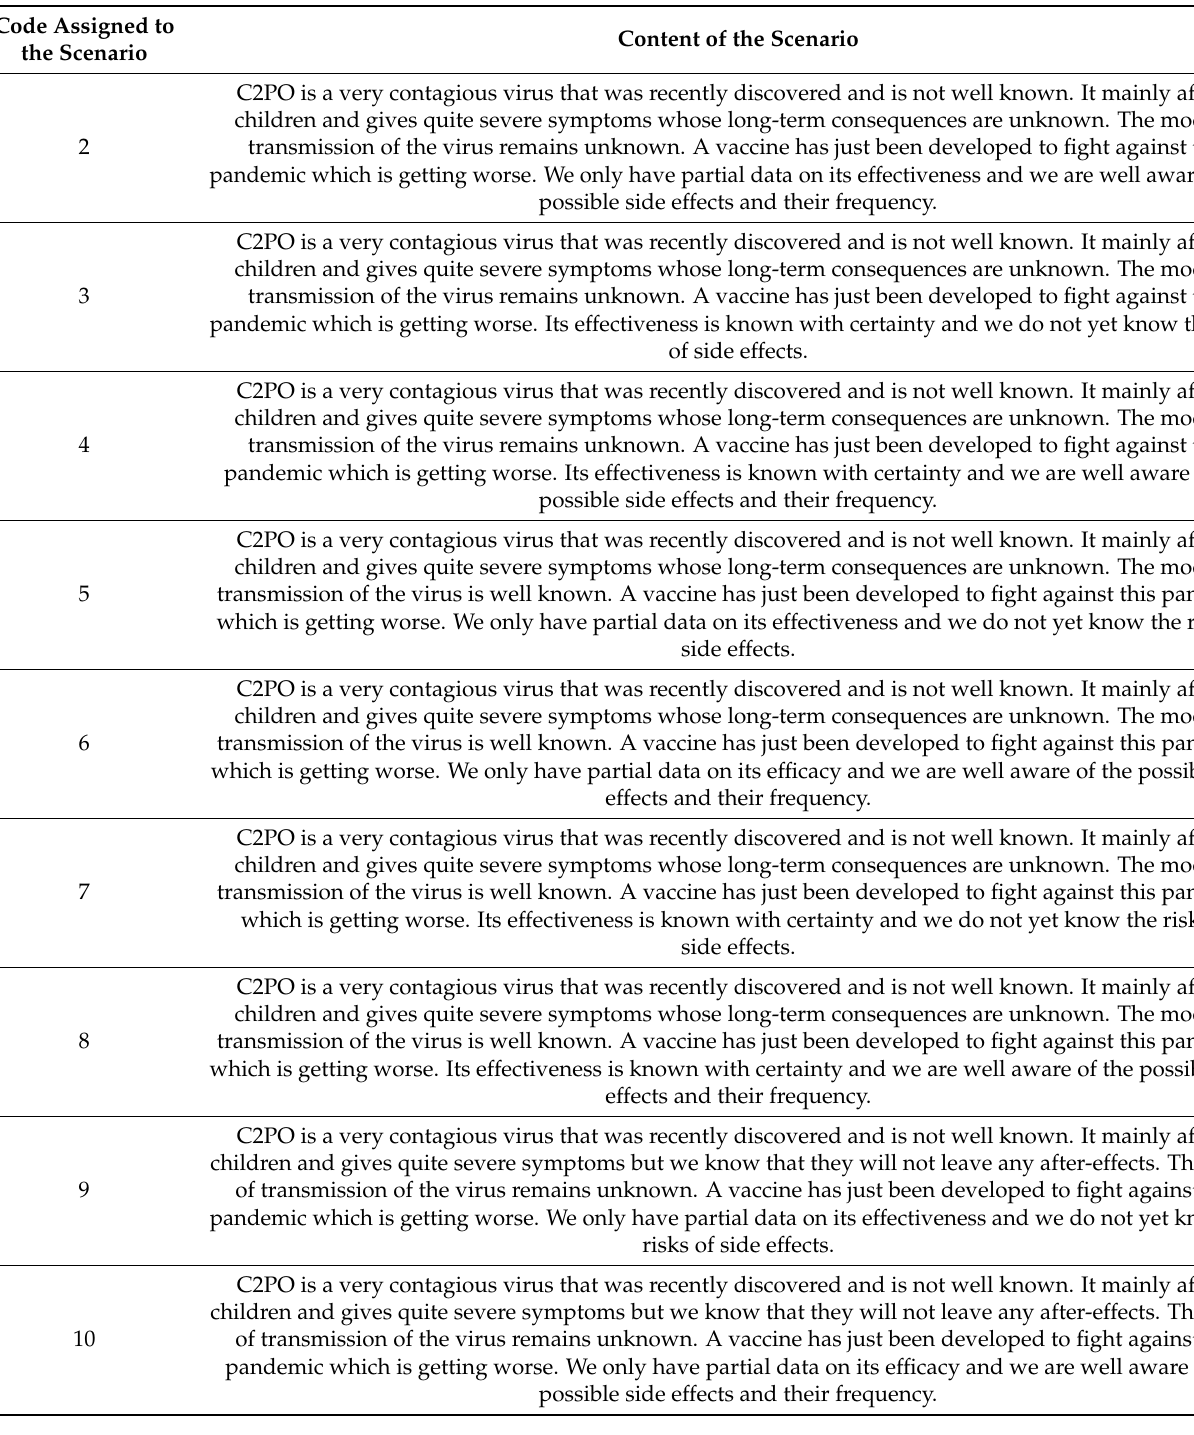
Table 2. Description of the content of the 30 scenarios presented in the pretest. Scenarios 1 and 32 were presented as references in the